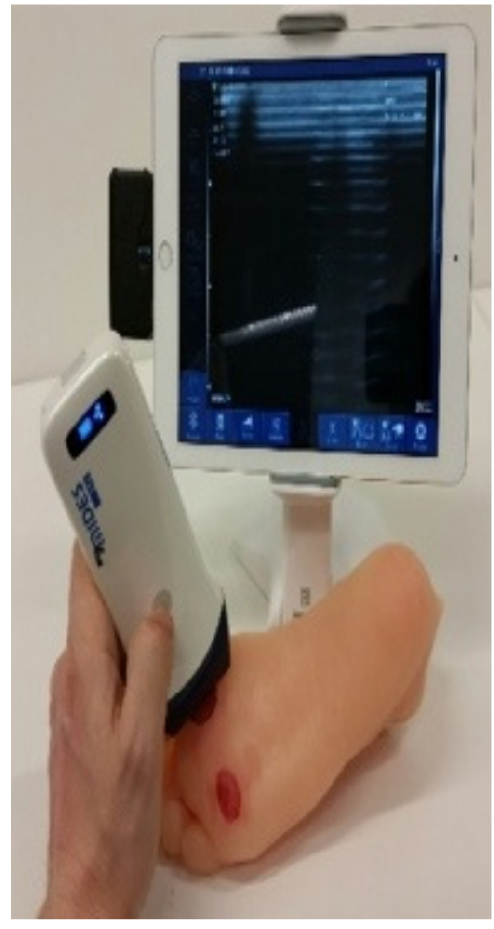
Figure 4. Depiction of the interface of the in-home (HOME) edition with the use of a thermal camera for diabetic foot ulcer